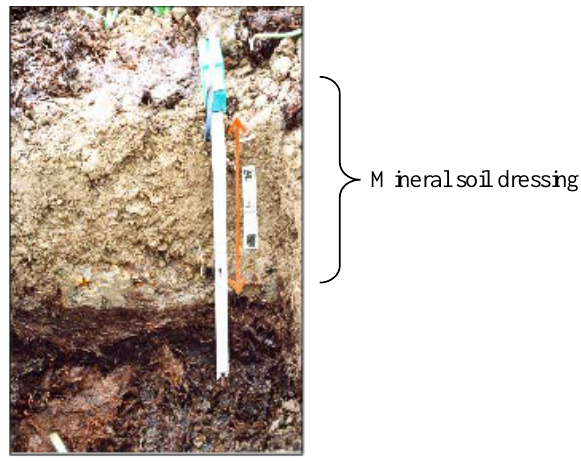
Figure 2. Mineral soil dressing on peatland in Kita-mura, near Bibai during 1960s. Table 1. Some physical characteristics of the investigated paddy field soils (initial soil at 0–10 cm depth).